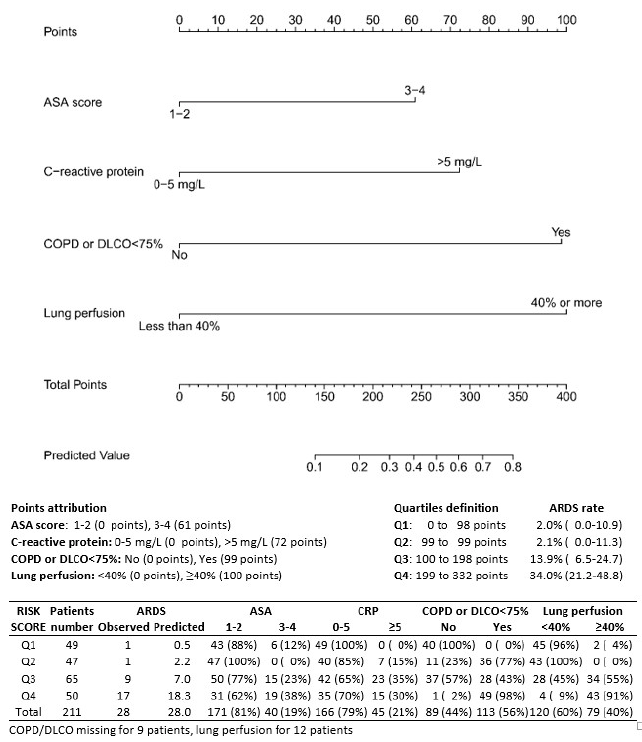
Figure 1. Nomogram for the prediction of ARDS; points attribution to different characteristics and division of the patients in 4 growing risk classes.